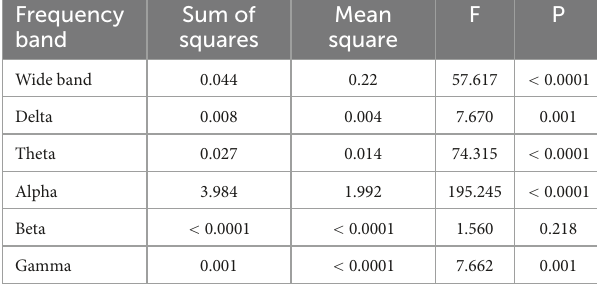
TABLE 3 One-Way ANOVA analysis of the mean values of brain networks in three groups of people (95% confidence interval).